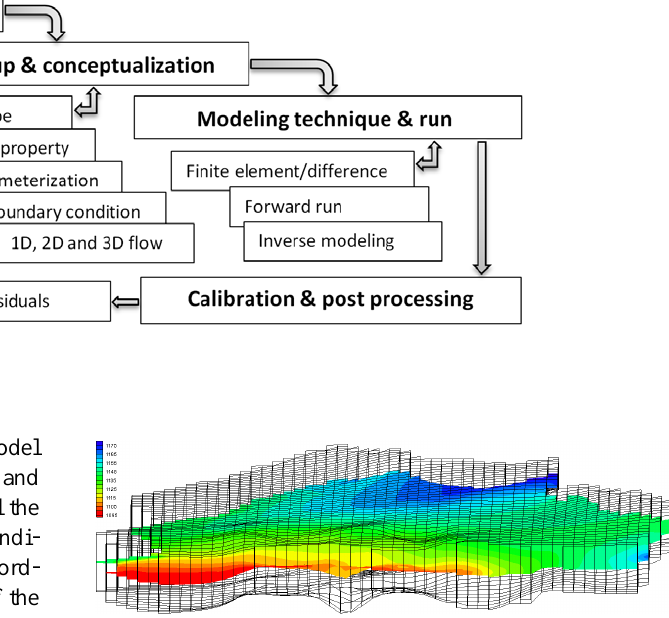
Fig. 4. Spatial discretization of the modeled area and the distribution of groundwater system (meters above mean sea level).